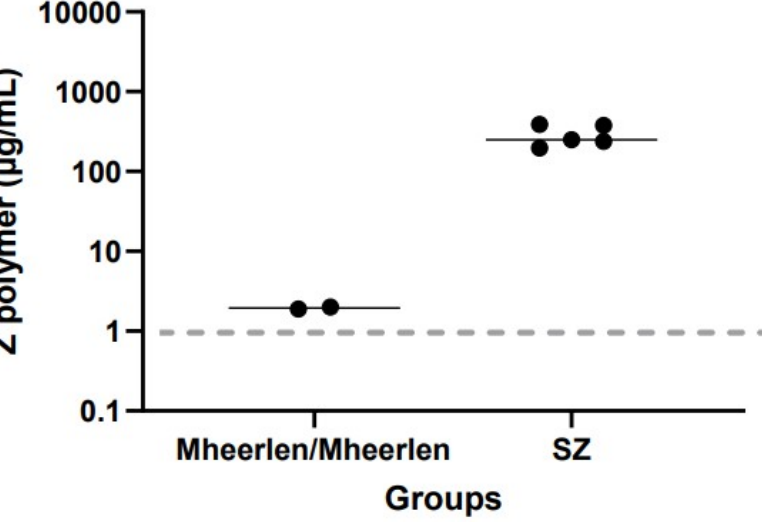
Figure 2. Z-AAT polymer levels in plasma of 2 patients homozygous Mheerlen genotype and 5 with phenotype SZ mutant of AATD. The dashed line represents the lower limit of detection of the assay. The line through the closed circles represents the median value.